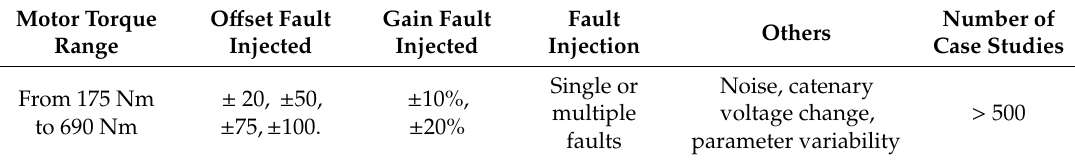
Table 3. Summary of hardware-in-the-loop (HIL) validation and case